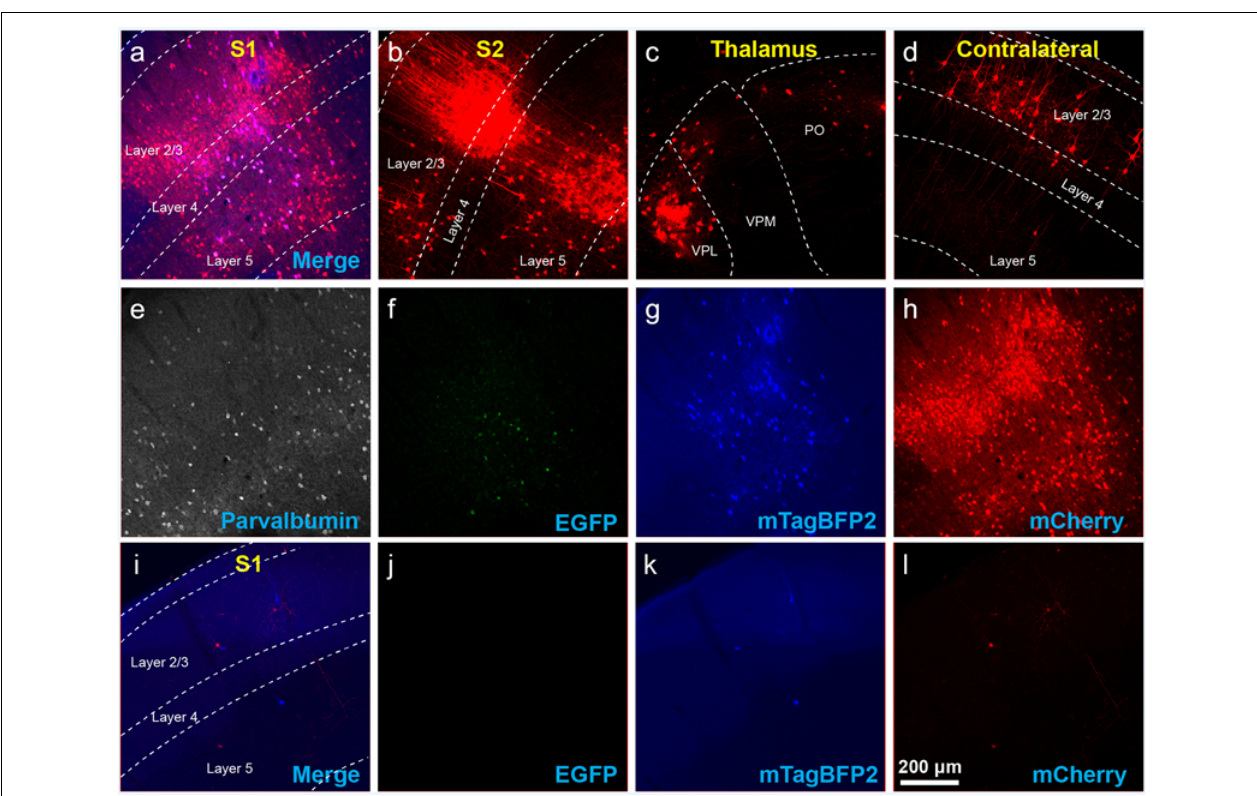
FIGURE 6 | Example results using recommended dilutions of two-helper combination. (A–H) Use of the two-AAV combination at 1:200 and 1:20 dilutions (see main text) labeled many presynaptic neurons. (A) Injection site in S1. Green = anti-EGFP staining, blue = mTagBFP2, red = mCherry. Individual channels from this field are shown in panels (E–H) . (B) Many labeled neurons were found in ipsilateral S2. (C) Many labeled neurons were found in ipsilateral thalamus (VPL, VPM, and Po). (D) Many labeled neurons were found in contralateral S1. (E–H) Individual channels from the field shown in panel (A) . (E) Anti-parvalbumin staining (not shown in panel A ). (F) Anti-EGFP staining, indicating expression from the first, Cre-dependent AAV. Note that, at this dilution, the EGFP signal is quite dim even with immune amplification. (G) mTagBFP2, indicating expression from the second, tTA-dependent AAV. (H) mCherry, indicating the presence of the ∆ G RV. (I–L) Injection site